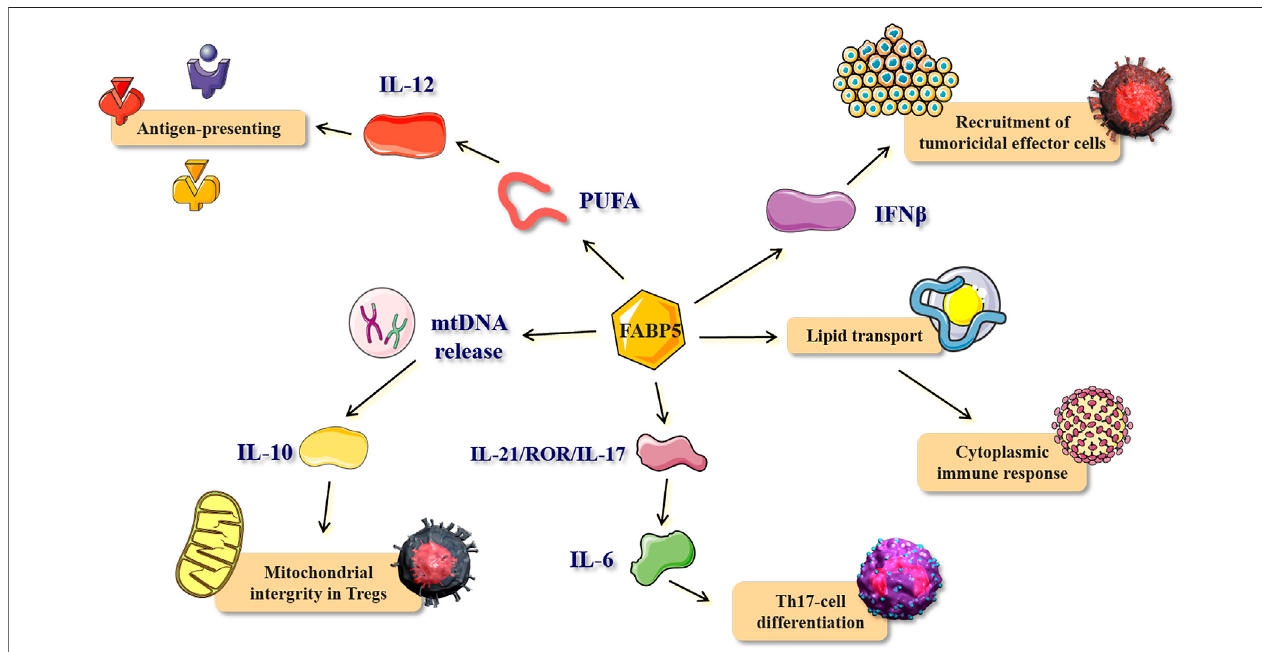
FIGURE 6 | The role and mechanism of FABP5 in immune response and in fl ammatory process. The bio-function and corresponding mechanisms of FABP5 in antigen-presenting, recruitment of tumoricidal effector cells, cytoplasmic immune response, Th17-cell differentiation, and mitochondrial integrity in Tregs. PUFA, polyunsaturated fatty